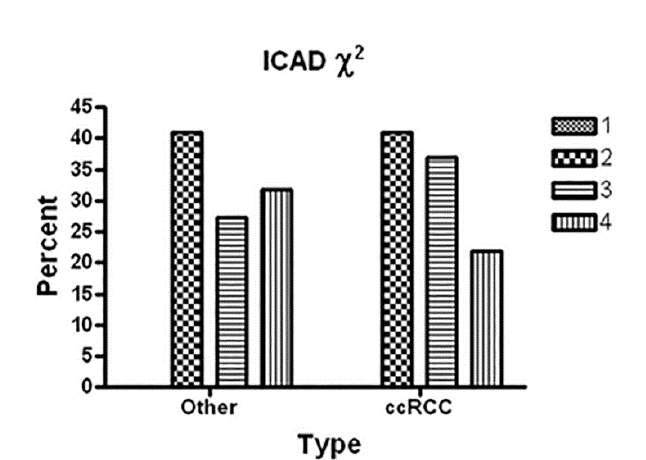
Figure 3. Graph of the  2 results for RCC subtype with ICAD protein intensity. The ICAD  2 analysis is shown, comparing percent of cases for clear cell RCC (ccRCC) with the other subtypes of RCC having differing intensity scores for protein expression (1 = no expression; 2–4 = low, moderate and high protein intensity). ccRCC was compared with all other RCC subtypes. The Pearson  2 was 1.1437 with a p value of 0.564, and a Fisher’s exact p value was 0.553. Thus, there were no significant